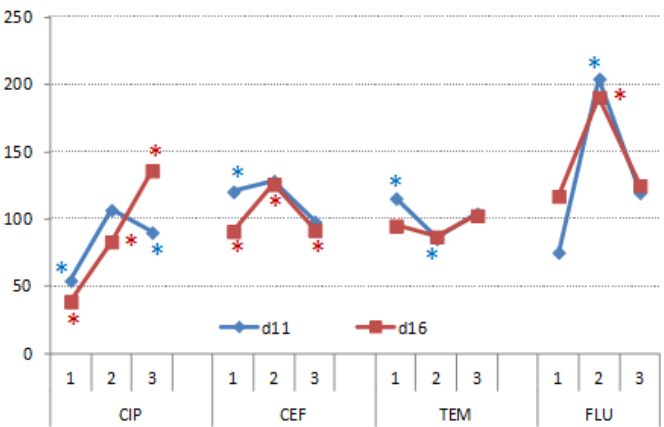
Figure 13. Root fresh weight of wheat germinated under CIP, CEF, TEM and FLU treatments and subsequently grown on complete nutrient solution, recorded in 11- and 16-day-old plants. The results are expressed relatively to respective controls (control = 100%). Asterisks mark values that were significantly different from respective controls.